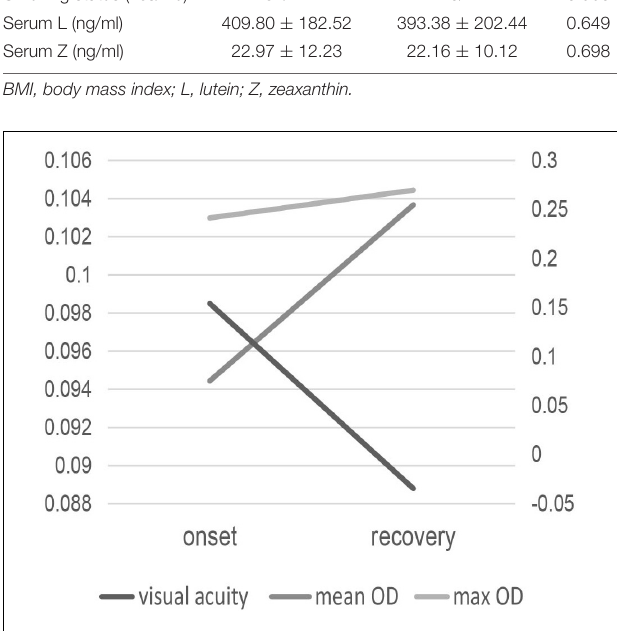
mean OD, and both were significantly reduced compared with the affected eyes ( p = 0.018 for max OD, p = 0.015 for mean OD, paired t